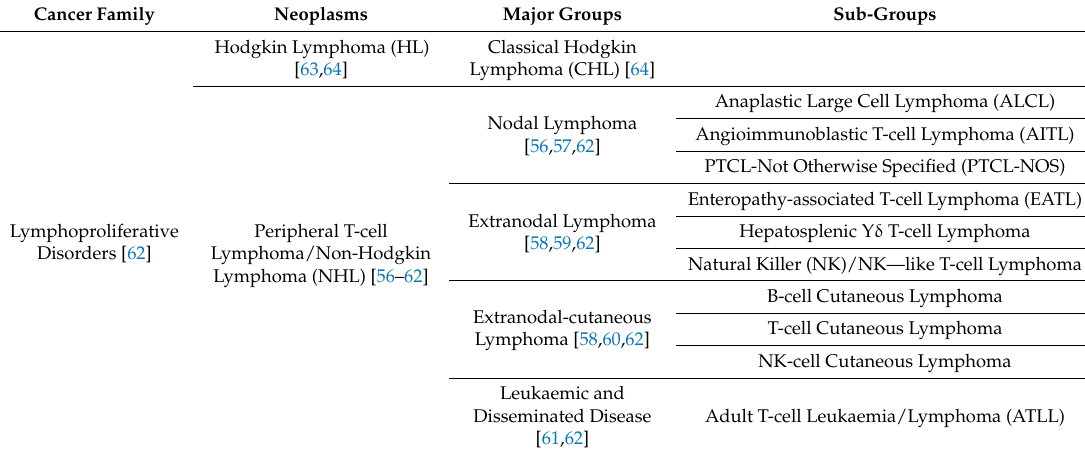
Table 1. Table of lymphoproliferative disorders. Lymphoid neoplasms were sub-grouped according to the World Health Organisation 2016 classification